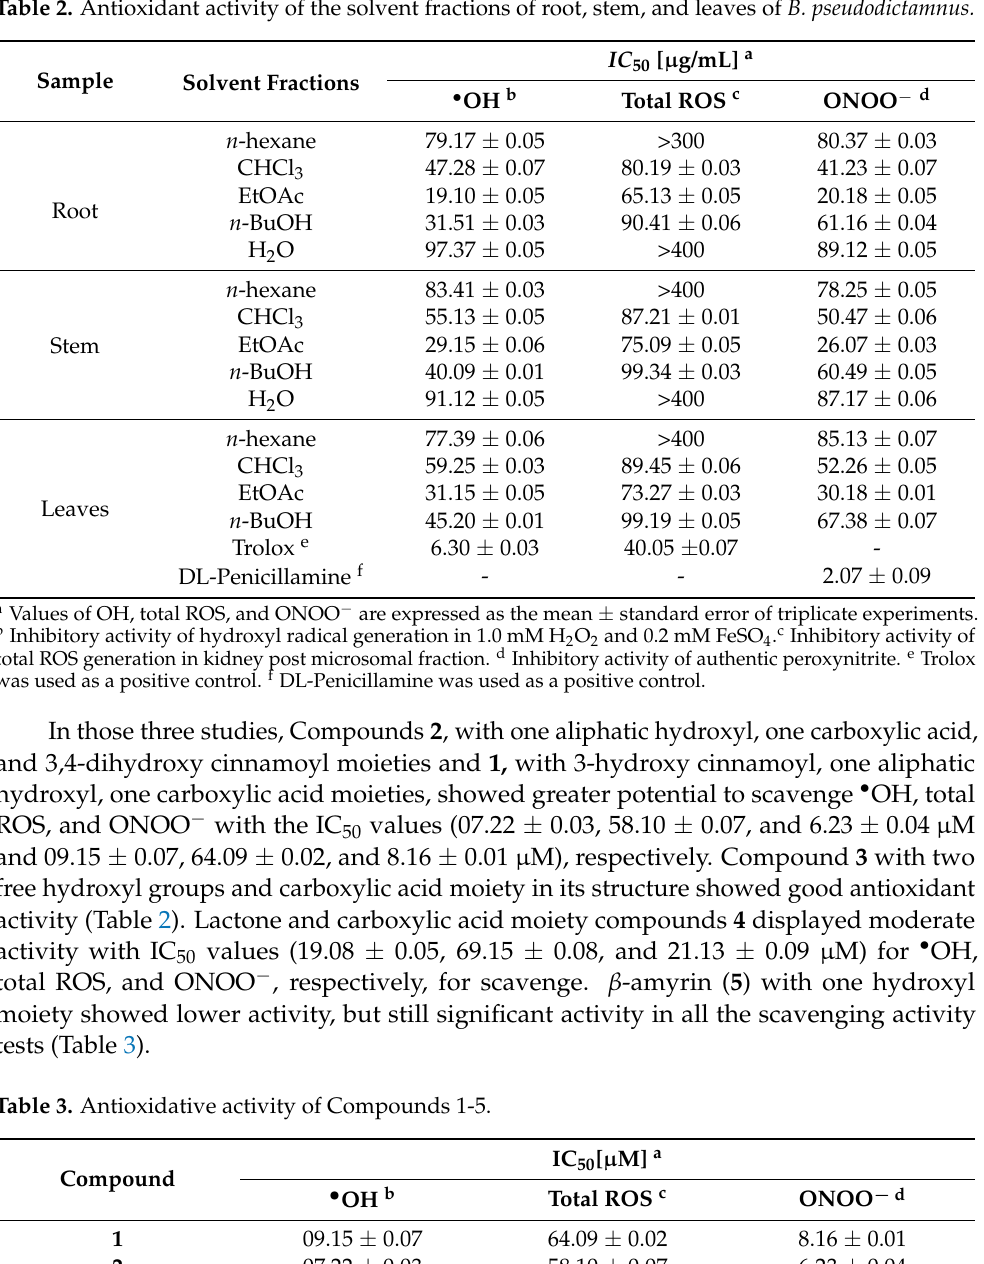
Table 2. Antioxidant activity of the solvent fractions of root, stem, and leaves of B. pseudodictamnus.